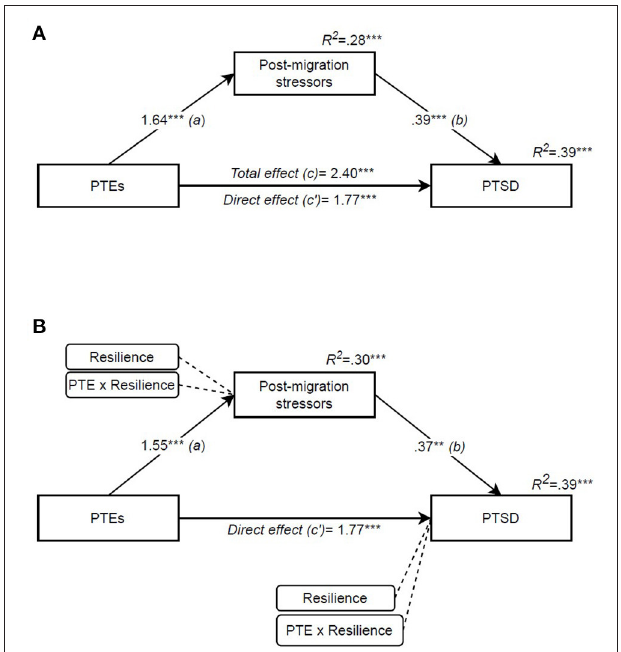
FIGURE 3 | Potentially traumatic events’ effect on PTSD mediated by post-migration stressors and moderated by resilience. (A) Mediation (PROCESS model 4), (B) Moderated mediation (PROCESS model 8). Independent variable: PTE [potentially traumatic events (RTHC)]. Mediator: post-migration stressors (RPMSS). Outcome: PTSD [post-traumatic stress disorder (CRIES-8)]. Moderator: resilience (CYRM-12). All coefficients are unstandardized. * p < 0.05, ** p < 0.01, *** p < 0.001.